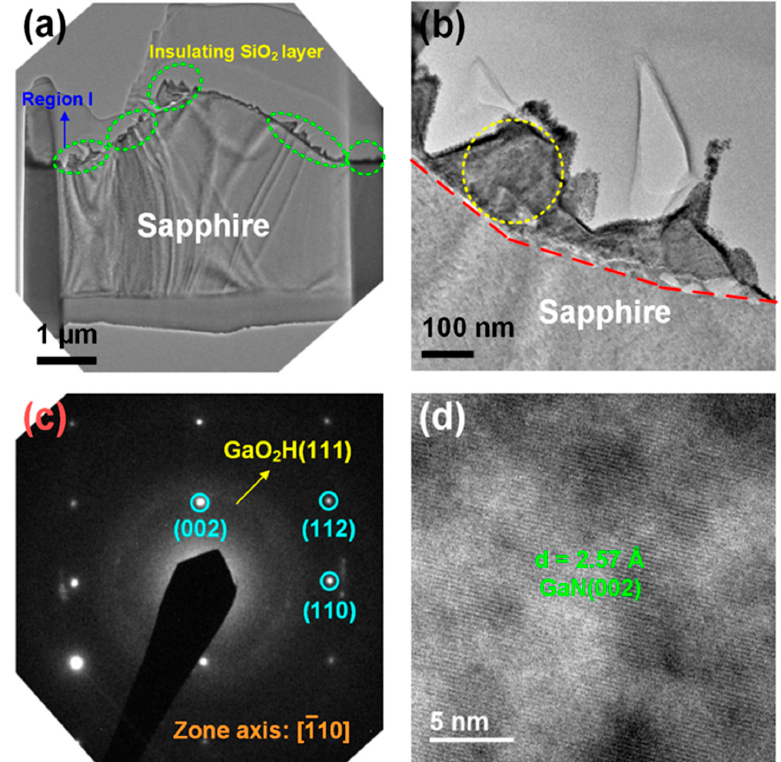
Figure 5. ( a ) Cross-sectional transmission electron microscopy (TEM) image of the GaN-epi/PSS sample decomposed at 1200 °C for 3 h under a gas-flow rate of 10 cm 3 /min; ( b ) TEM image of region I taken at higher magnification; and ( c , d ) SAED pattern of region I and an high resolution transmission electron microscopy (HR–TEM) image, respectively, focused on the yellow-circled area in ( b ).